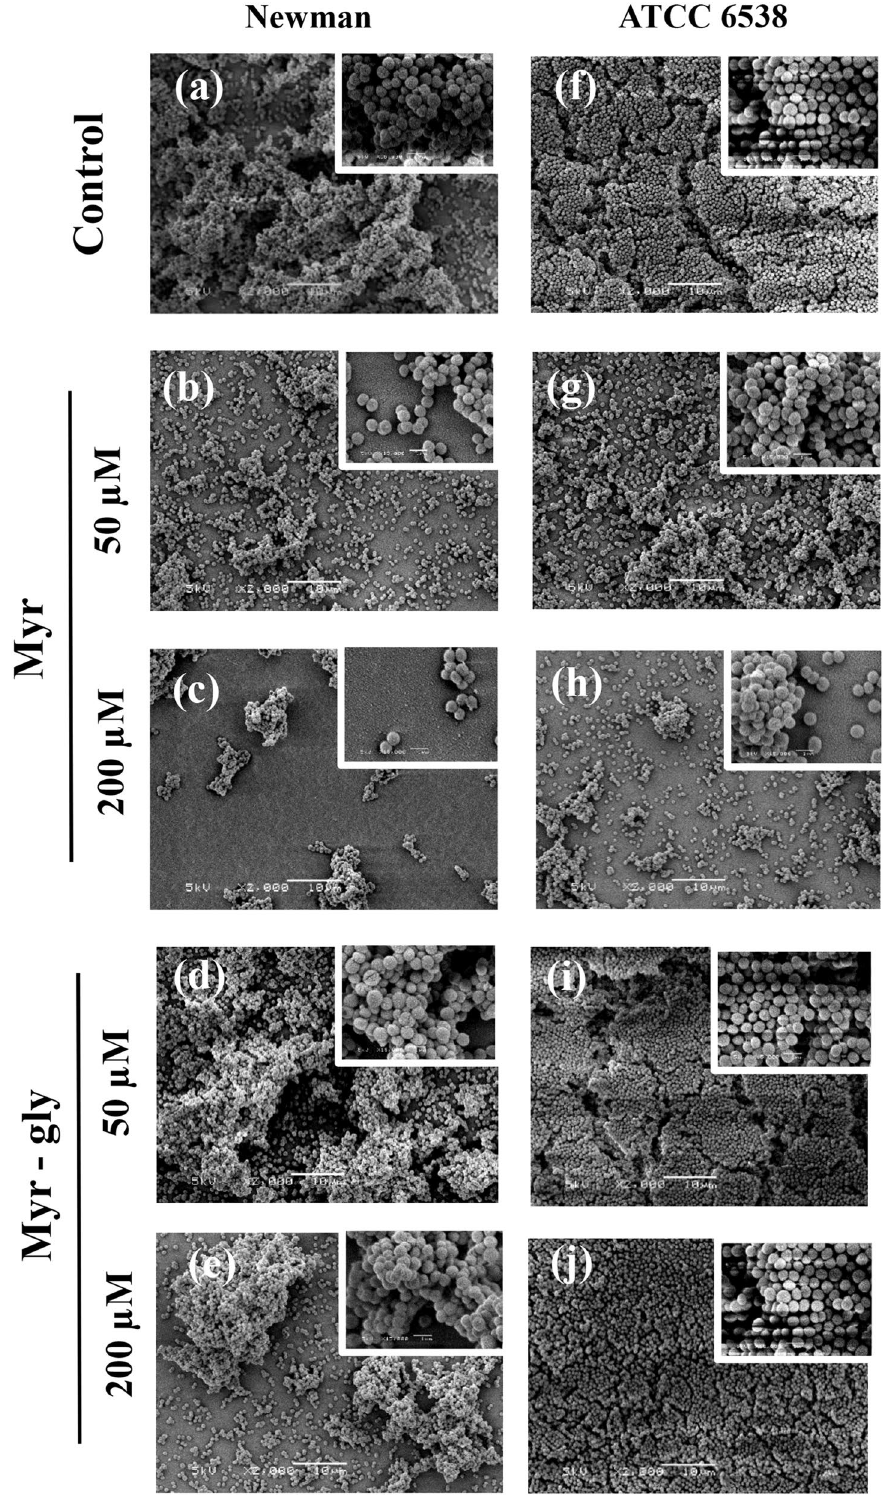
Figure 2. Scanning electron microscopy (SEM) images of biofilms. ( a–c ) S. aureus Newman treated with 0, 50 and 200 µ M of Myr. (d , e ) S. aureus Newman treated with 50 and 200 µ M of Myr-gly. (f–h ) S. aureus ATCC 6538 treated with 0, 50 and 200 µ M of Myr. ( i , j ) S. aureus ATCC 6538 treated with 50 and 200 µ M of Myr-gly. Scale bars: 10 µ m (inserts in the images represent 1 µ